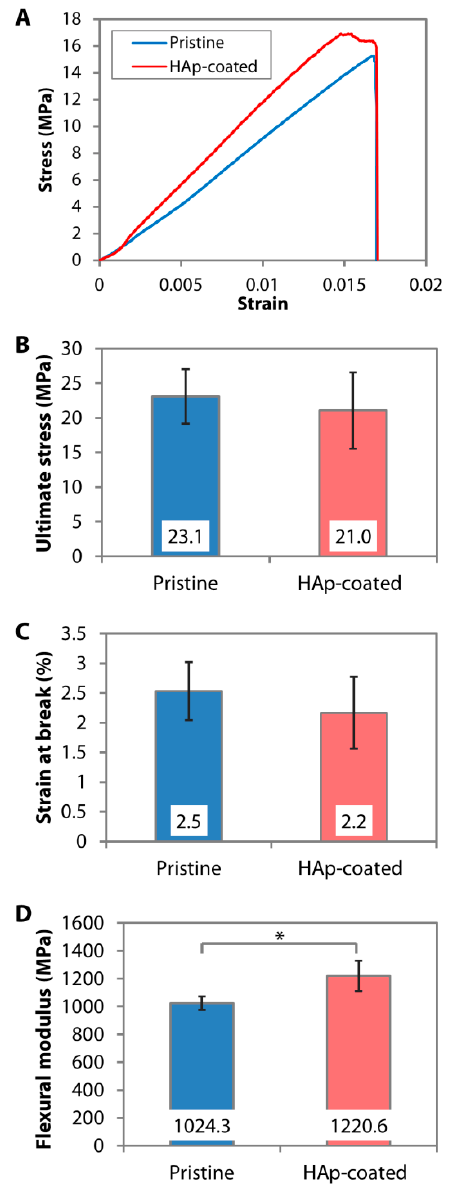
Figure 4. Mechanical properties of pristine and dip-coated PMMA. HAp nanoparticles were immobilized on the PMMA sheets via dip-coating. ( A ) Representative stress-strain curves generated from 3-point bending tests of the PMMA sheets. ( B – D ) Ultimate flexural stress, strain at break, and flexural modulus of pristine and dip-coated PMMA sheets. * p < 0.05.